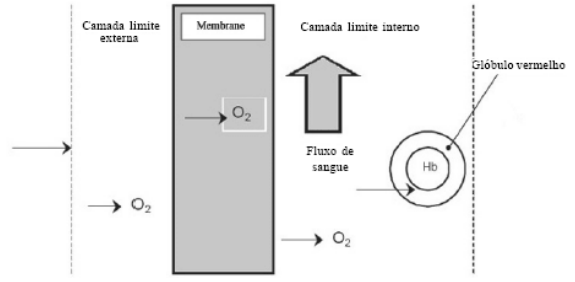
Fig. 1 - Esquema da difusão de oxigênio através de uma membrana